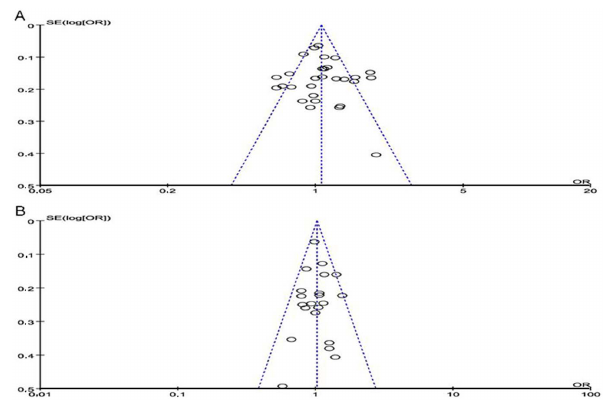
Figure 3. Funnel plot of publication bias for b 2AR polymor- phism under recessive genetic model. A) Arg/Gly16; B) Gln/Glu27. Funnel plot with pseudo 95% confidence limits was used.